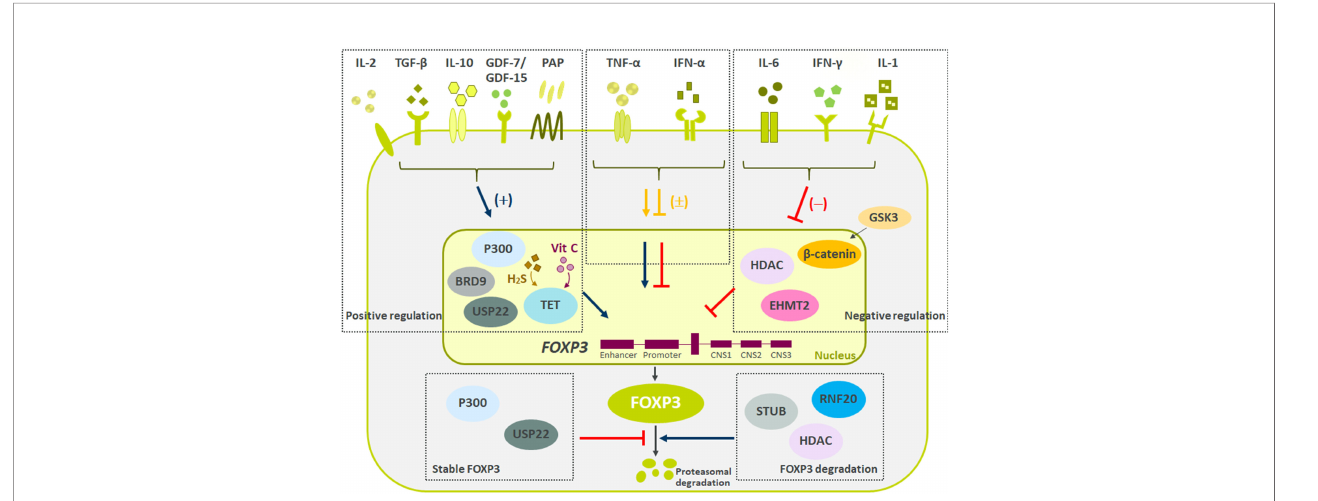
FIGURE 2 | Summary of negative and positive regulators of FOXP3 expression. Reviewed here are recent molecules driving Tregs stability and function. Multiple secreted proteins have shown both positive (IL-2, TGF- b , IL-10, GDF7/15, PAP), negative (IL-6, IFN- g , and IL-1), and mixed (TNF- a and IFN- a ) effects on Treg biology. Besides secreted proteins, multiple pathways in fl uencing FOXP3 methylation, ubiquitination and acetylation have recently been described. These changes to FOXP3 ultimately led to difference in Tregs suppressive capacity and stability. Finally, pathways regulating FOXP3 protein degradation are critical to maintain Treg cell lineage and